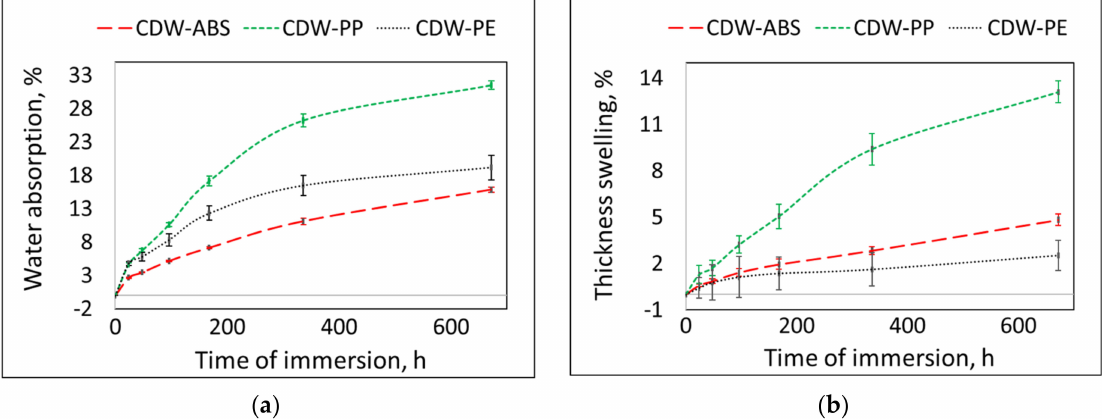
Figure 3. Water absorption ( a ) and thickness swelling ( b ) of the studied materials. The results consist of average values, with error bars describing the standard